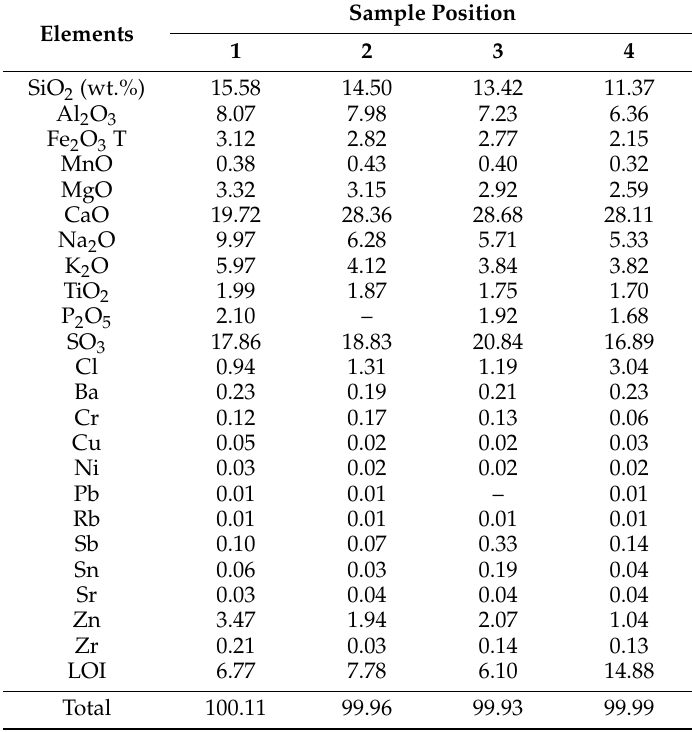
Table 3. Results of X-ray fluorescent (XRF) analyses from surface deposits of an uncooled test